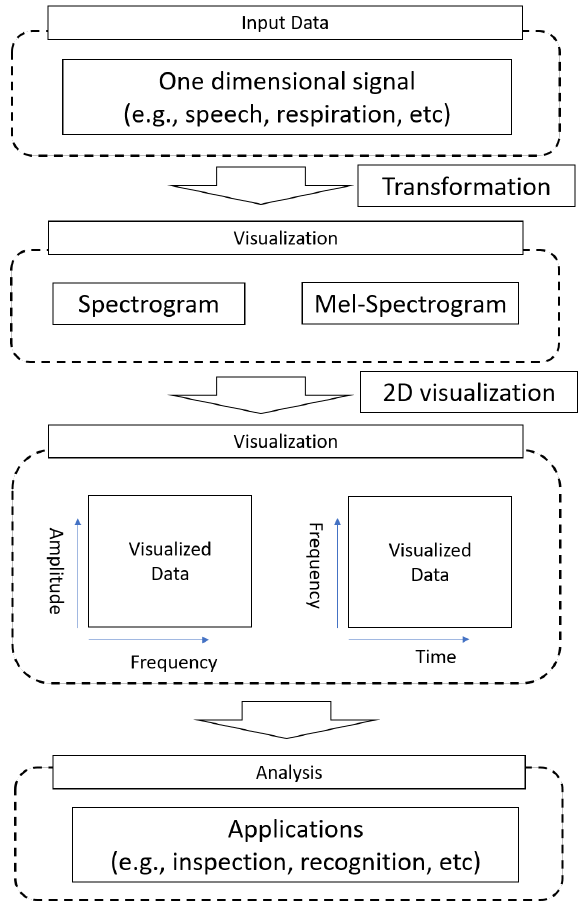
Figure 2. Existing research on the visualization